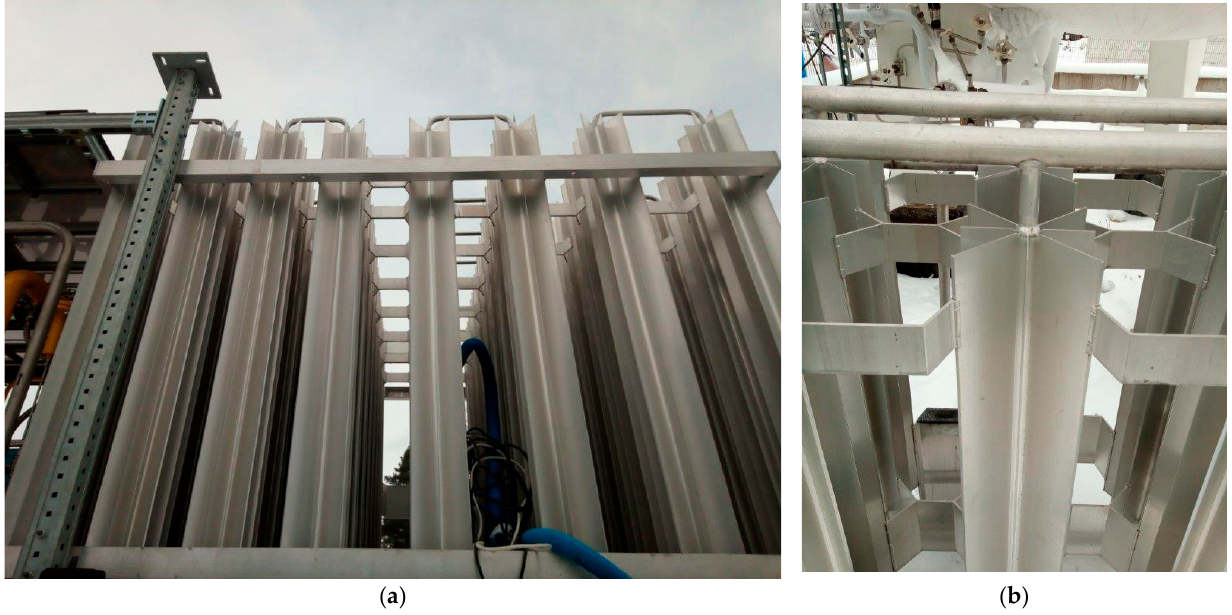
Figure 1. Ambient air vaporizer ( a ) general view; ( b ) detailed view on the aluminum finned